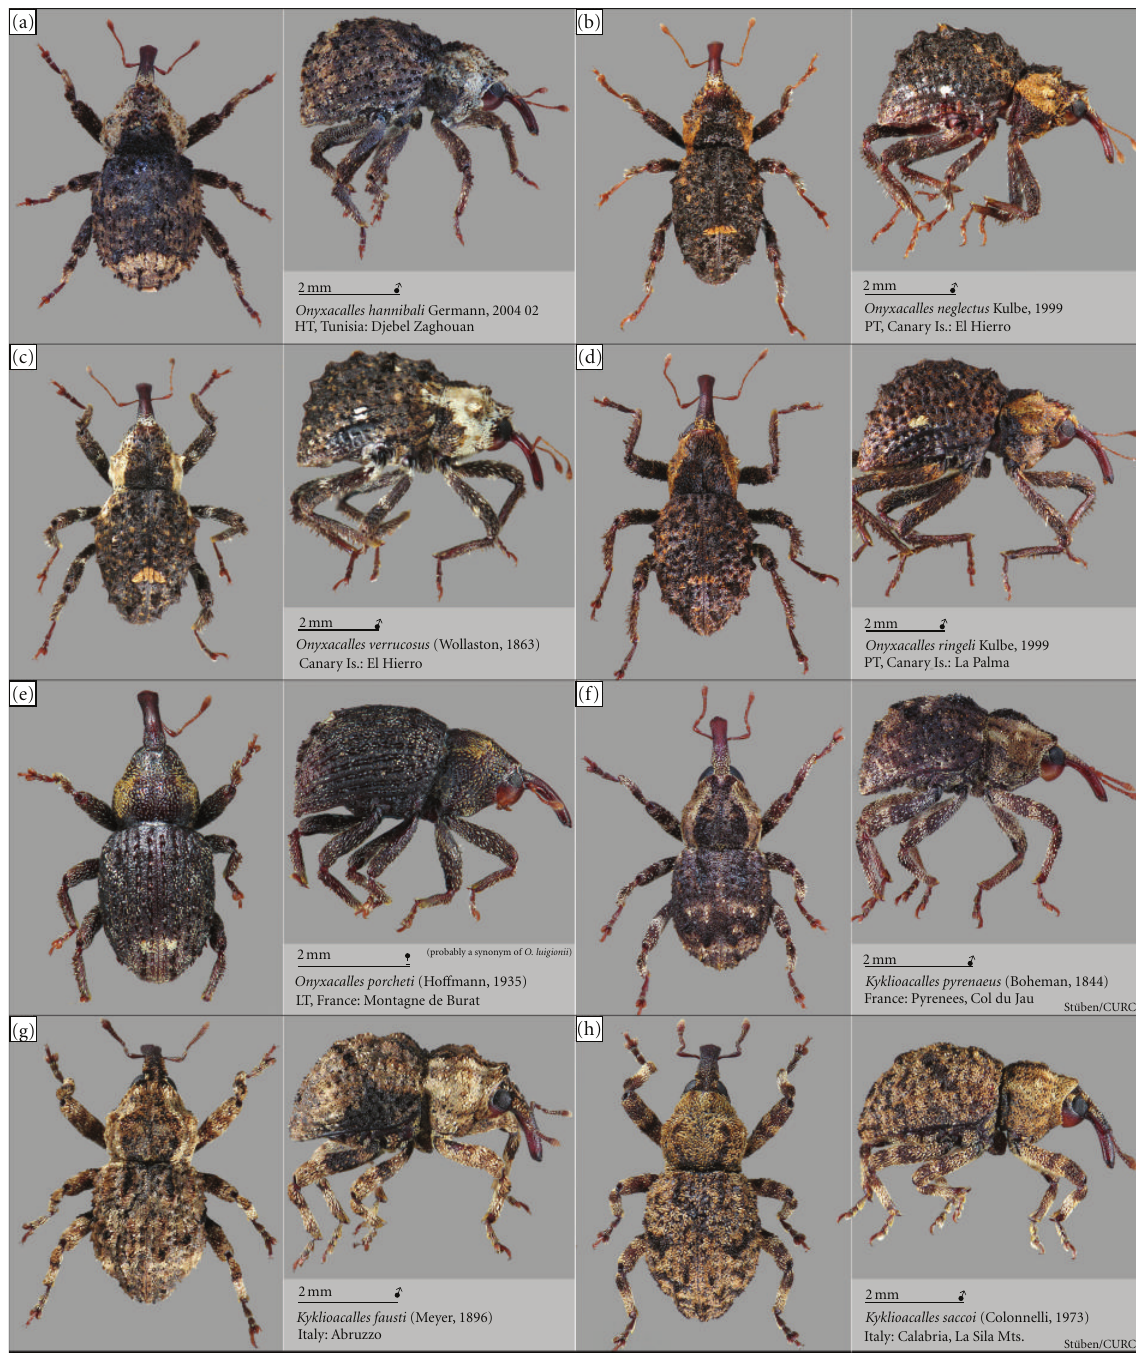
Figure 8: (a): Henoni group — O. hannibali (see also the other species of this group: Figures 5(a), 5(d), 5(g), 5(k)); (b–d): subgenus: Araneacalles — O. neglectus (b) , O. verrucosus (c), and O . ringeli (d); (e): O. porcheti (perhaps O. luigionii ); (f): Kyklioacalles pyrenaeus ; (g) K. fausti ; (h) K. saccoi ; all habitus (dor./lat.).